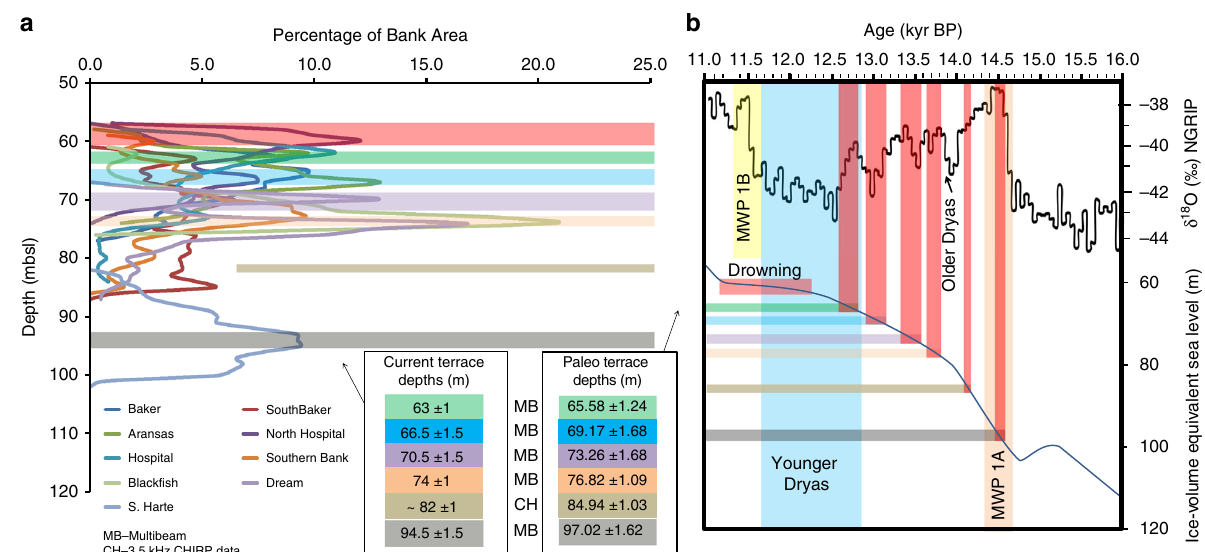
Fig. 5 Punctuated sea-level rise events over timescales of decades to century based on coralgal reef terrace levels and their connection with warming intervals in the North Greenland Ice Core Project climate record during last deglaciation. a Hypsometric curves for nine south Texas shelf drowned banks, based on high-resolution multibeam bathymetry data and 3.5 kHz seismic lines, identify the occurrence of a series of terraces common to the banks. Each depth range (mbsl) of the four common shallower terraces is based on the multibeam data sets, green (63 ± 1 m), blue (66.5 ± 1.5 m), purple (70.5 ± 1.5 m), and orange (74 ± 1 m). Two of those terraces (purple and orange), in addition to a deeper one at 82 ± 1 m, are also identi fi ed on the 3.5 kHz seismic lines (Fig. 4). An additional terrace level is identi fi ed on the multibeam map of Harte bank (deepest bank): gray (94.5 ± 1.5 m). b Paleo terrace depths (Table 1) with uncertainties are projected onto the ice-volume equivalent sea-level curve 15 . The age equivalent of each terrace is projected onto the NGRIP δ 18 O record 41,42 with associated uncertainties (red vertical bands). The Younger Dryas interval is represented by a blue band. Melt water pulses (MWP) 1A and 1B are represented by vertical light red and yellow bands